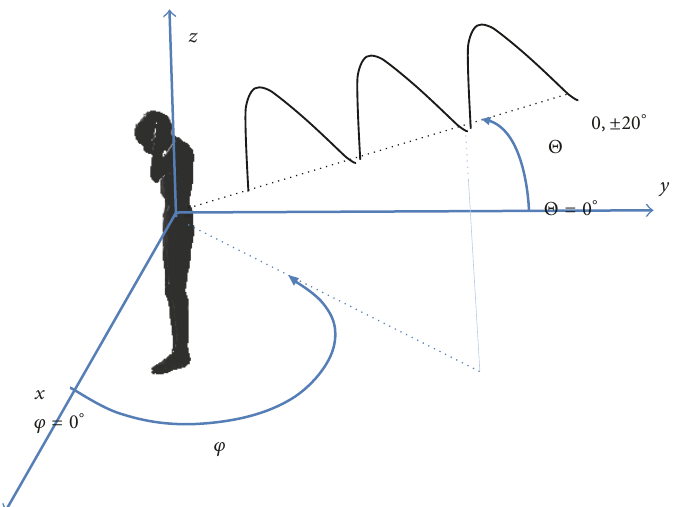
Figure 10: Definition of the parameters involved in the study of the exposure to a single plane wave.